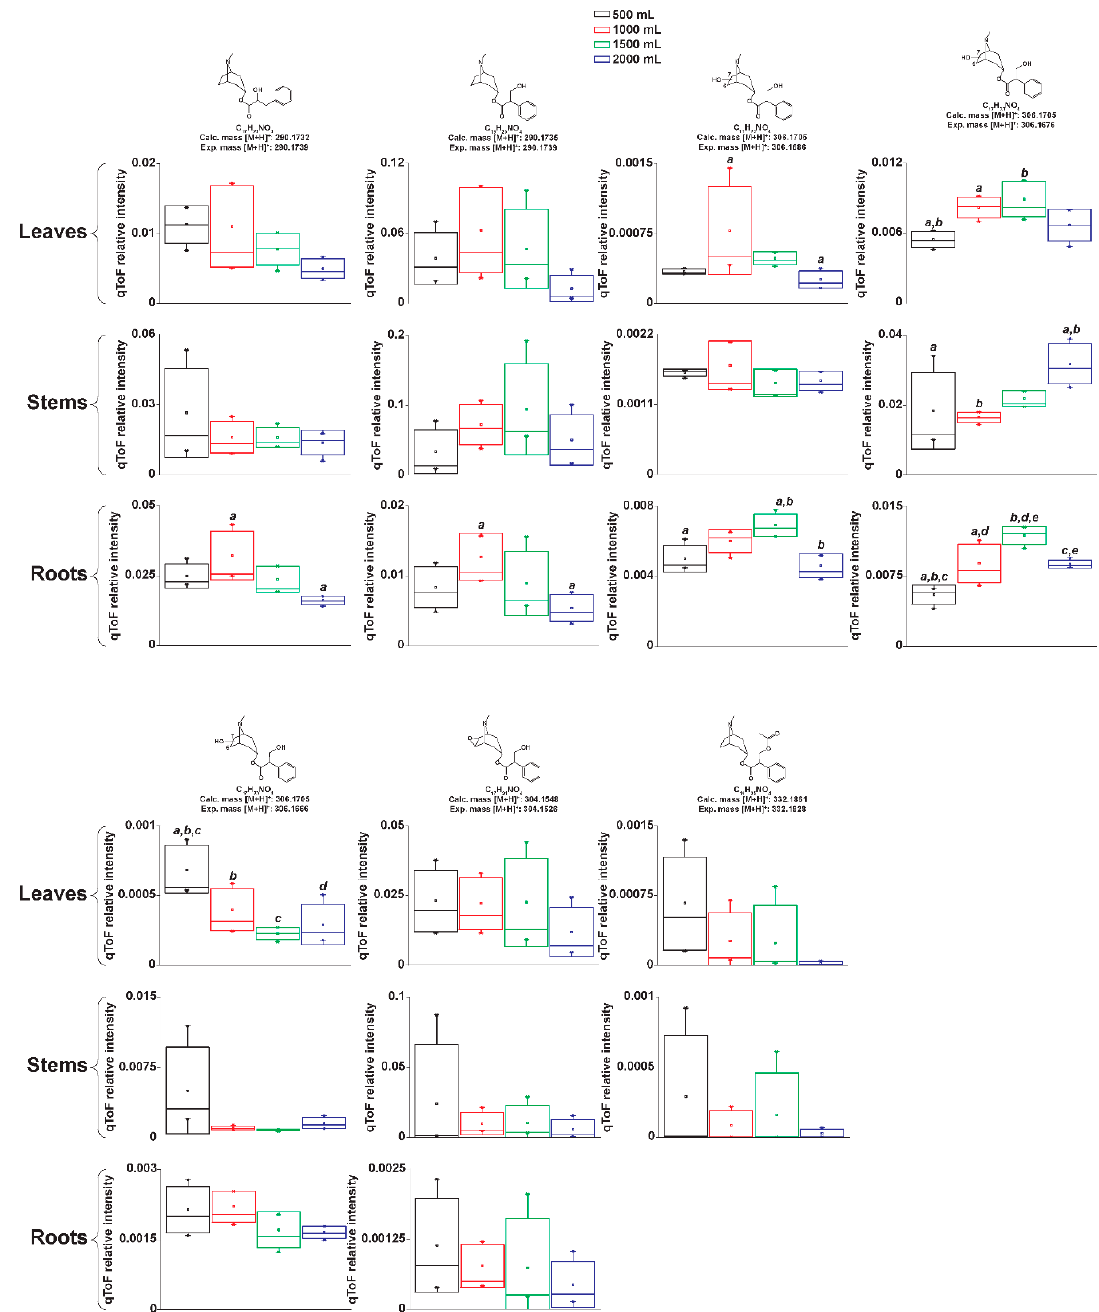
Figure 3. Aromatic tropane alkaloids and their relative concentrations in Datura stramonium grown under different irrigations. Atropine and scopolamine were identified by comparison against commercial standards. All other structures are predictions based on their mass spectra. Box plots show the standard deviation. Letters above bars represent significant pairwise differences according to Tukey test (ANOVA p ≤ 0.05).